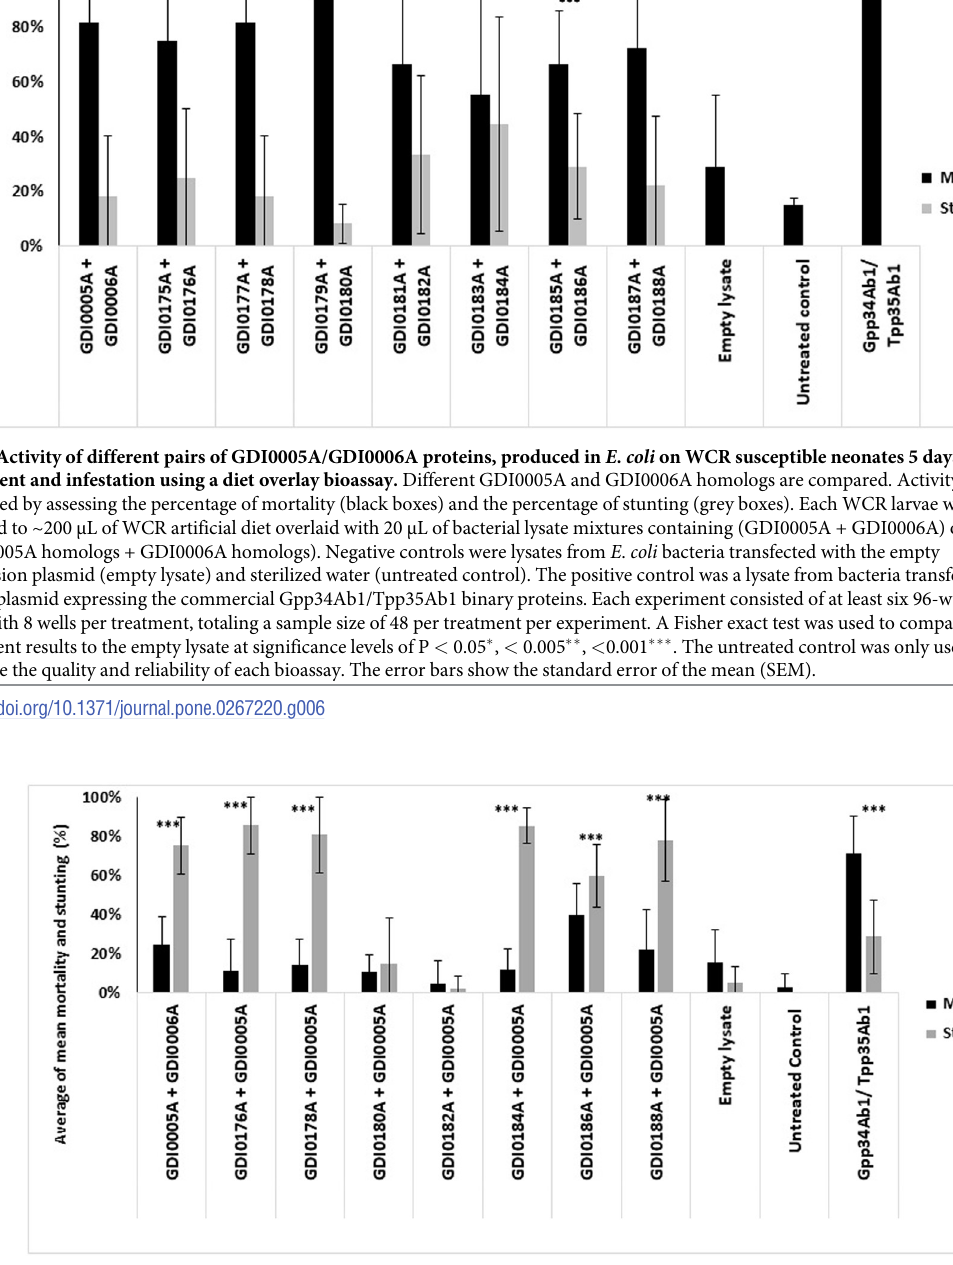
PLOS ONE | https://doi.org/10.1371/journal.pone.0267220 February 17,